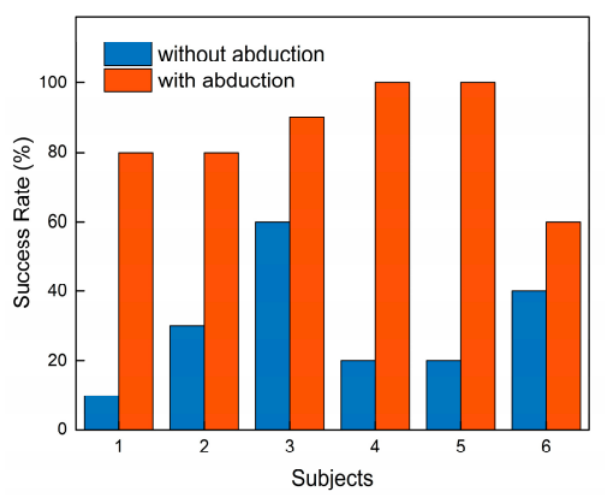
Figure 10. Comparison of grasping success rate with and without abduction of a soft robotic